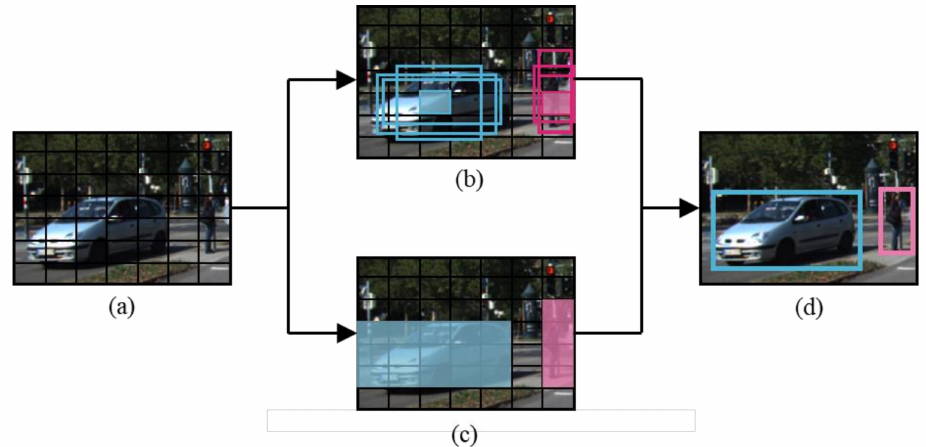
Figure 2. YOLO process for object detection: ( a ) the image is divided into S × S grid cells, ( b ) pre- dicted bounding boxes and their confidence scores, ( c ) probability map with class-specific confidence scores, and ( d ) detected objects and